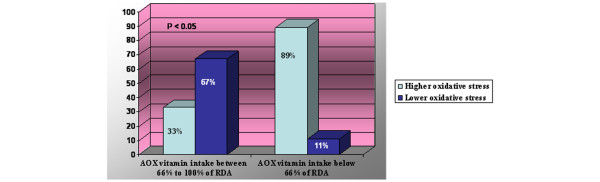
Worsening in oxidative stress according to intake of antioxidant vitamins. AOX, antioxidant; RDA, recommended dietary allowance.